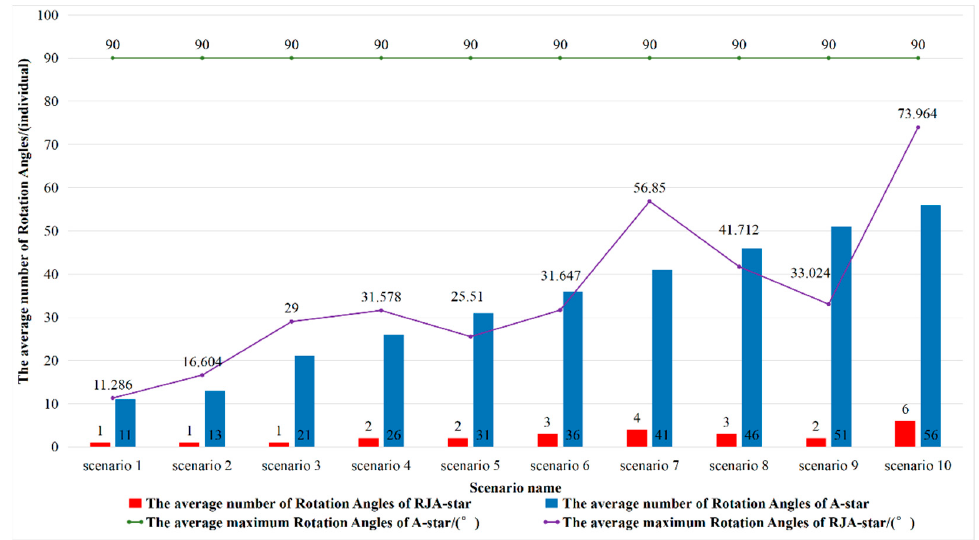
Figure 11. Comparison of the number of corners and the maximum angle between the two algo- rithms.